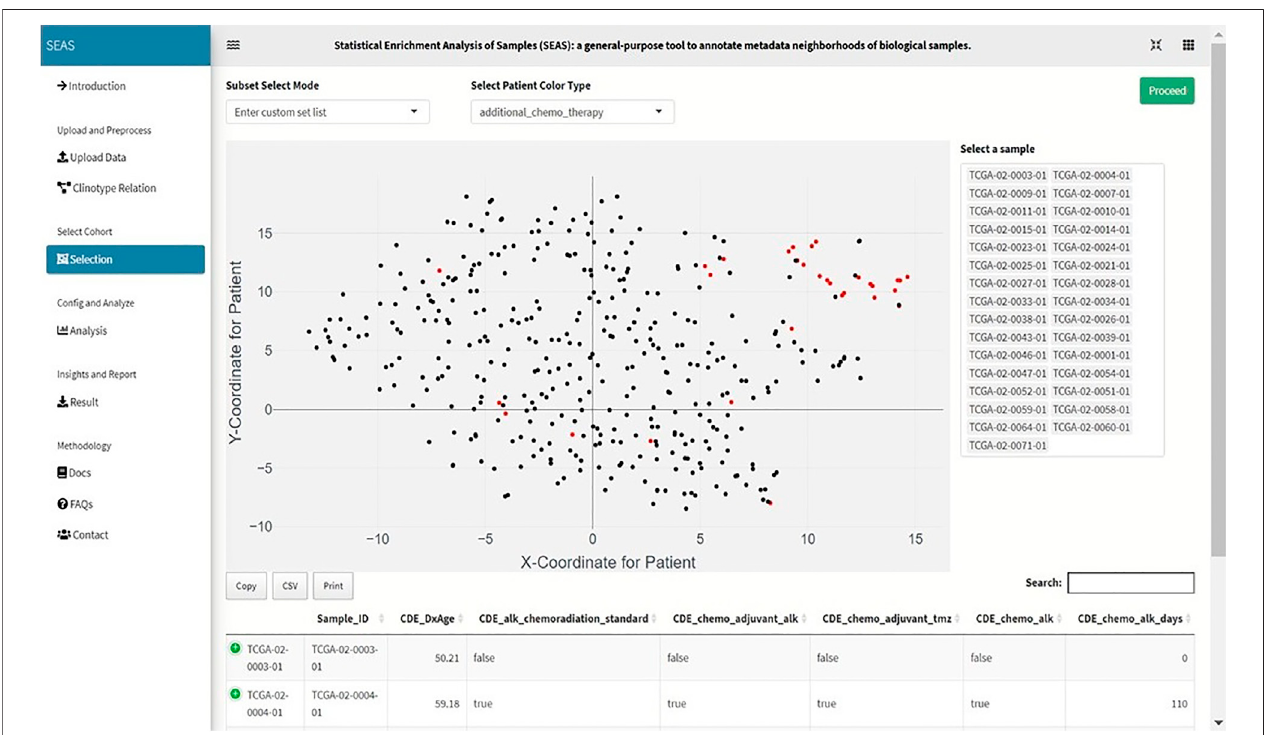
FIGURE 2 | Screenshot showing that SEAS visualizes the TCGA-GBM patients using embedding, and the user manually selects the subcohort.